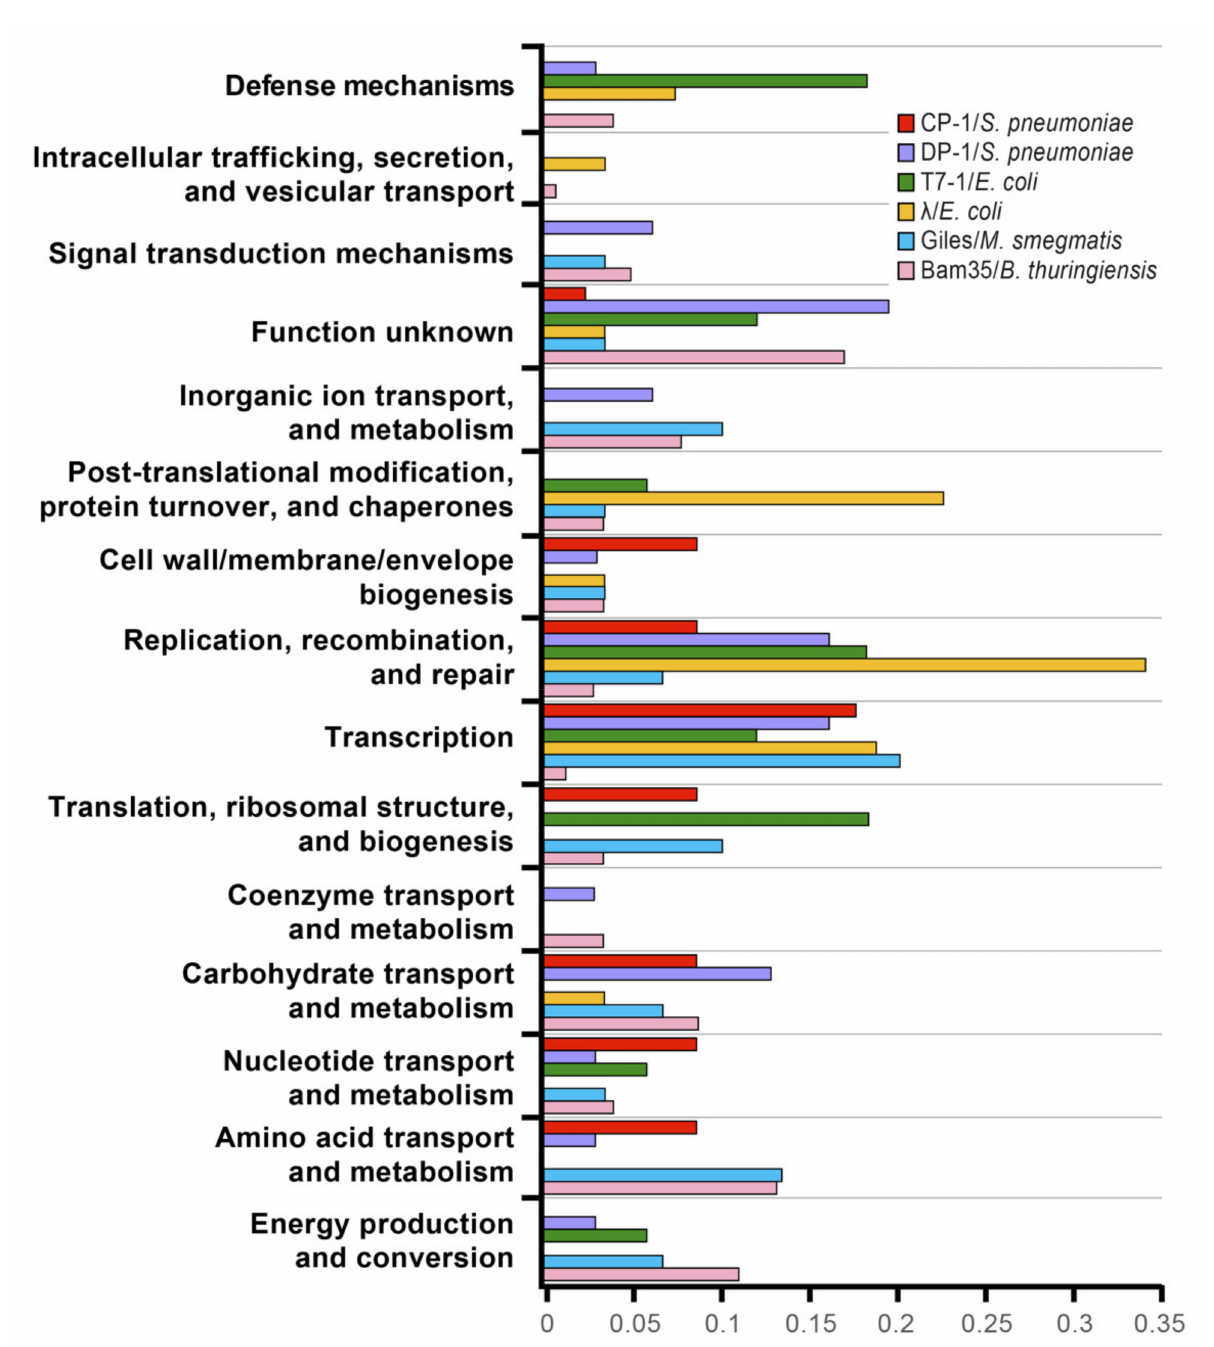
Figure 4. Interactions between functional groups of proteins. Stacked bar chart representing the proportion of interactions between the functional groups of Bam35 and the COG groups of B. thuringiensis . The X-axis represents the percentage of interactions that involved a defined COG group out of the total interactions that involved a defined Bam35 functional group. The number of total interactions is indicated for each combination inside the